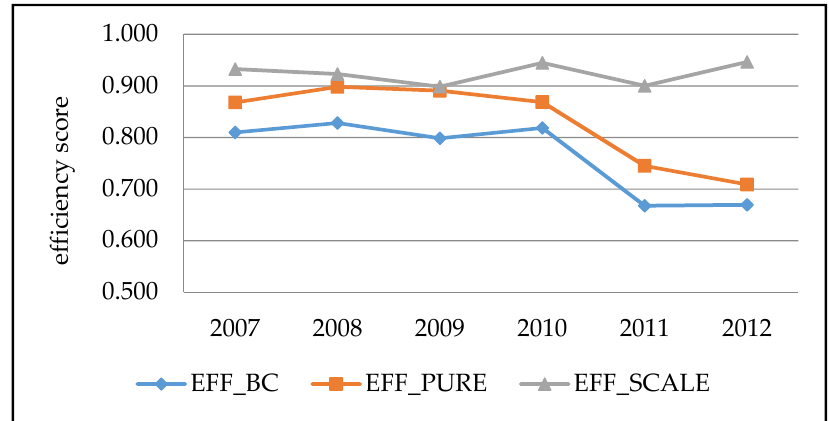
Figure 1. Bias ‐ corrected overall technical efficiency scores and their components in the case of all MENA Islamic banks (Panel A) between 2007 and 2012. EFF_BC: bias ‐ corrected overall technical efficiency scores; EFF_PURE: pure technical efficiency; EFF_SCALE: scale efficiency.